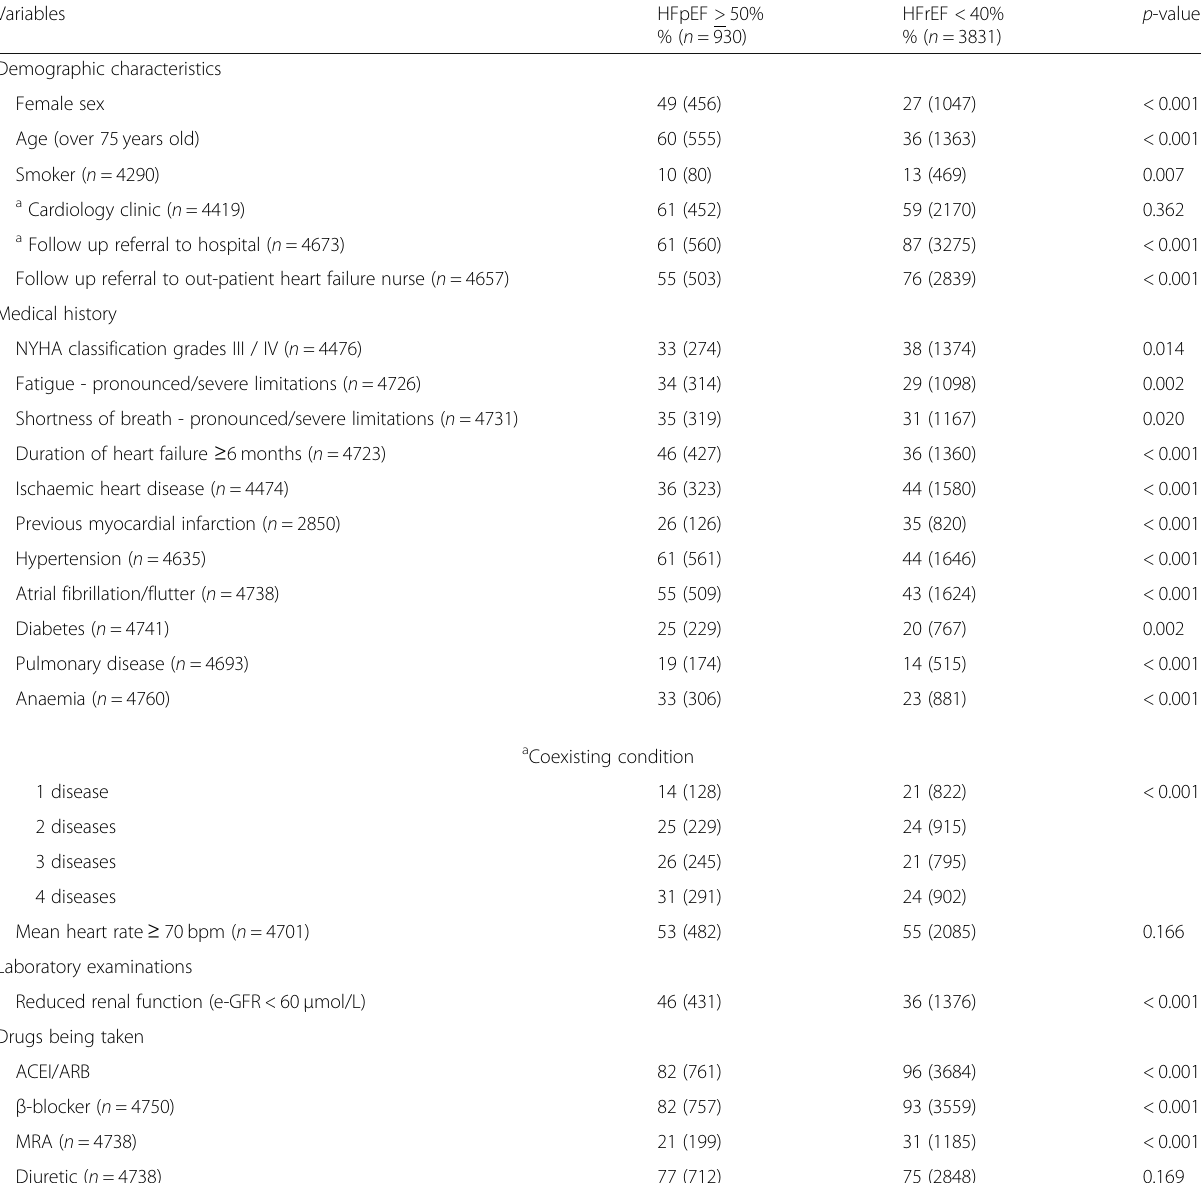
Table 1 Baseline characteristics % (n) for the two study groups HFpEF (> 50%) and HFrEF (< 40%) n = 4761